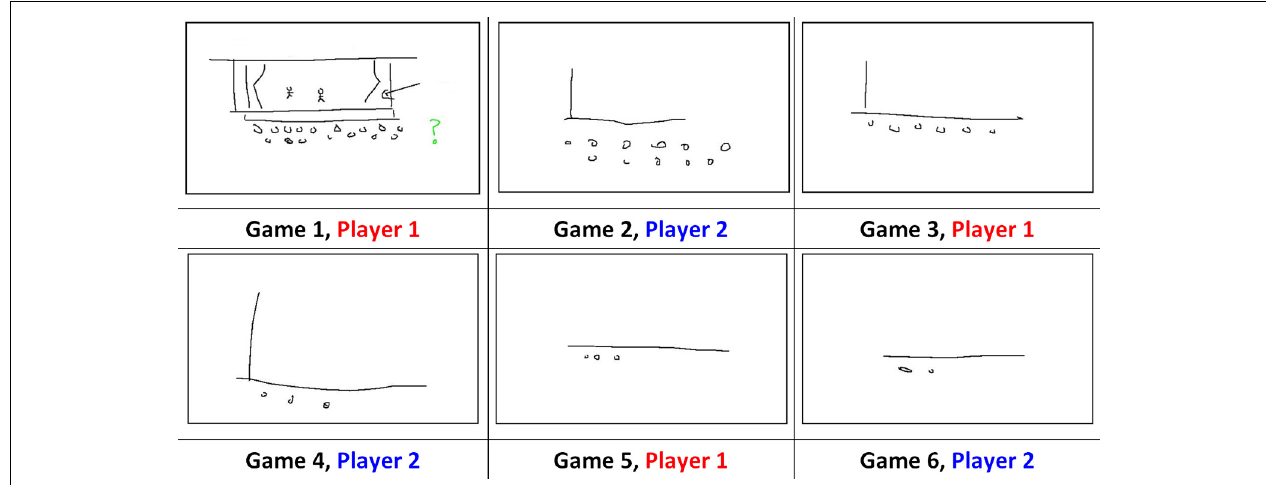
FIGURE 1 | Sign refinement and alignment for the item Theatre across six games between a pair playing the Pictionary-like task (Figure 1 from Fay and Ellison, 2013). Participants alternate directing and matching roles from game to game.